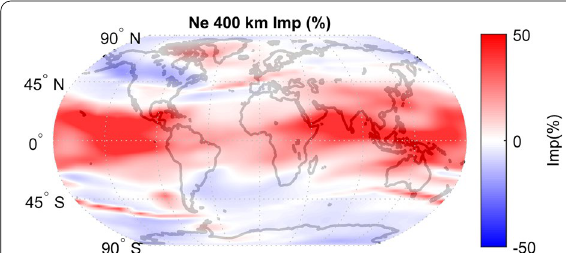
Fig. 6 Electron density global improvement at 400 km between analysis and reference with respect to the B‑Spline model for the complete storm (quiet, main phase and recovery days). The main area of improvement (red) is around the equatorial area between ( 45) ◦